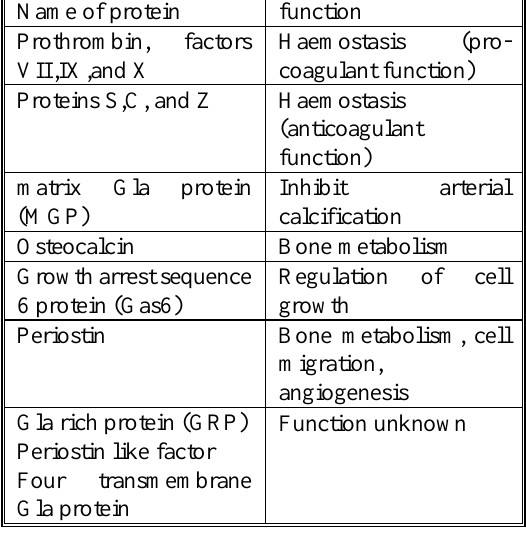
Gamma-carboxyglutamate proteins Table 2. Types and functions of 17 Gla-proteins